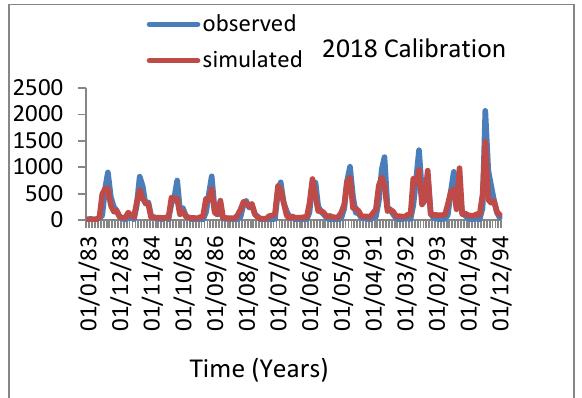
Table 21 Streamflow characteristics during validation phase